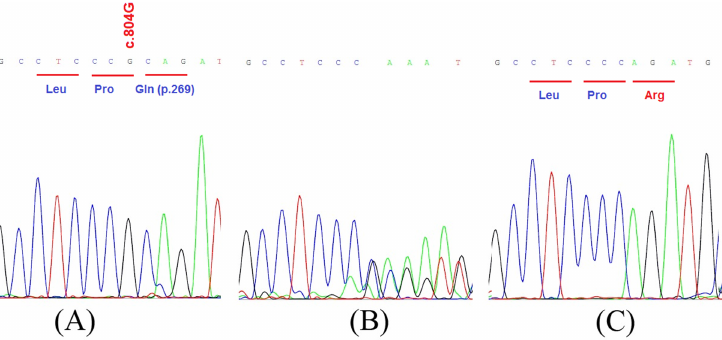
Fig 2. Electropherograms. Homozygous normal individual(A), Heterozygousindividual(B), and affected individual with the c.804delGpathogenicvariant in the ILDR1 gene(NM_001199799.1) (C).